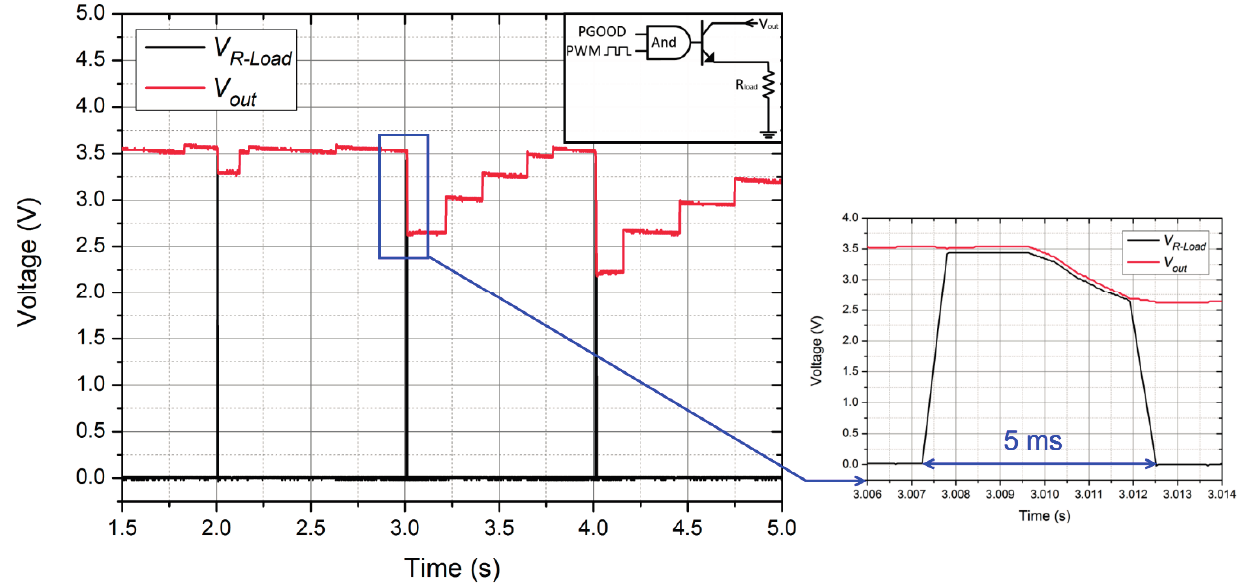
Figure 10. Performance of the power supply